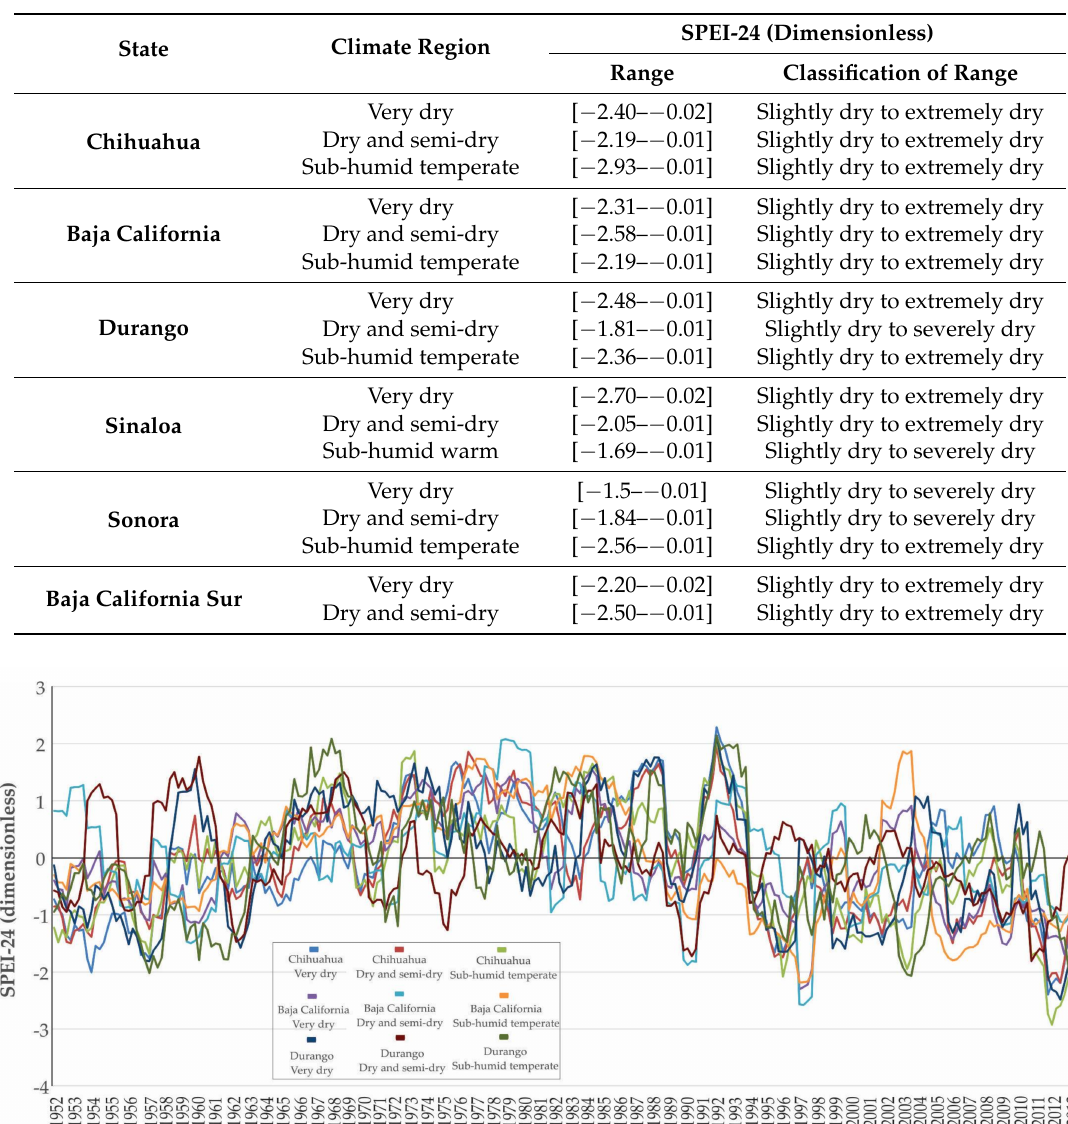
Table 5. Variation, extreme events and classification of SPEI-24 by climate region in northern Mexico. Source: Authors, following SPEI database (http://sac.csic.es/spei/, 2018) and INEGI climatic classification (http://www.cuentame.inegi.org.mx/monografias/).